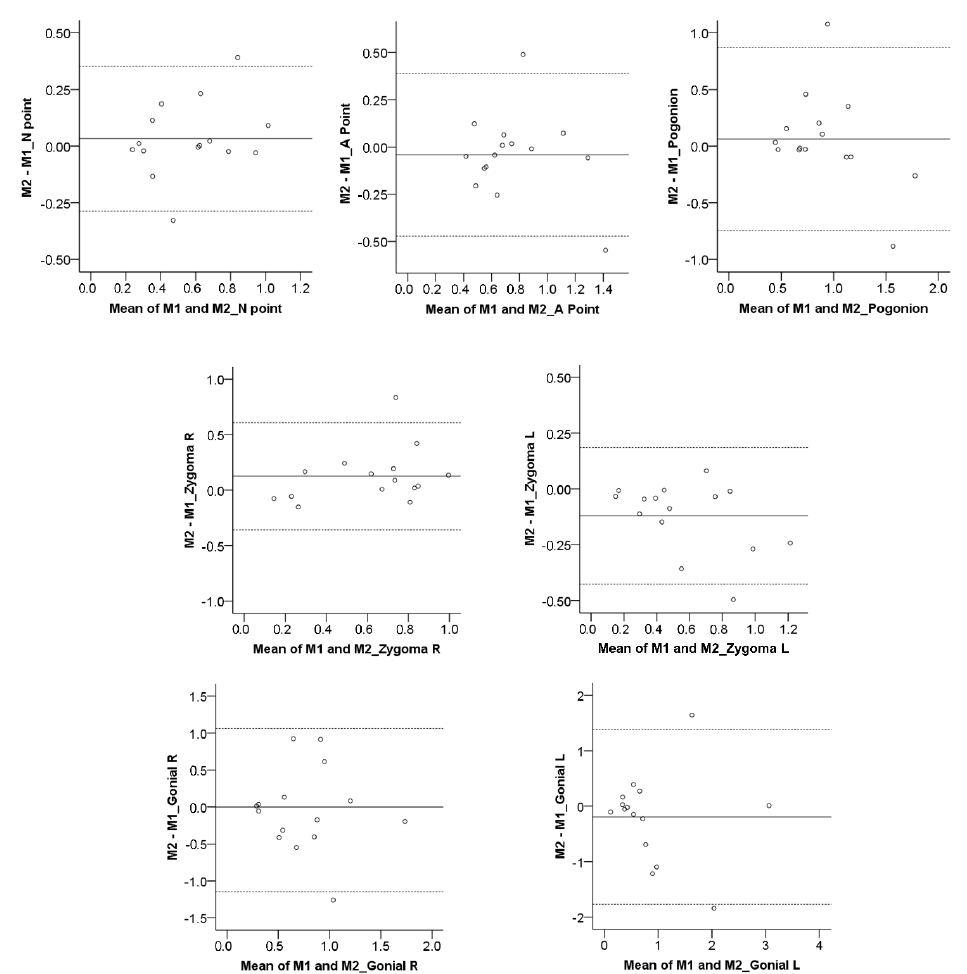
Figure 3. Bland – Altman plots of the T0 – T1 changes (mm) detected through repeated MACB superimpositions by the same operator. The continuous horizontal line shows the mean of the differences in the detected T0 – T1 changes, and the dashed lines show the corresponding 95% Limits of Agreement. M1: Measurement 1; M2: Measurement 2.